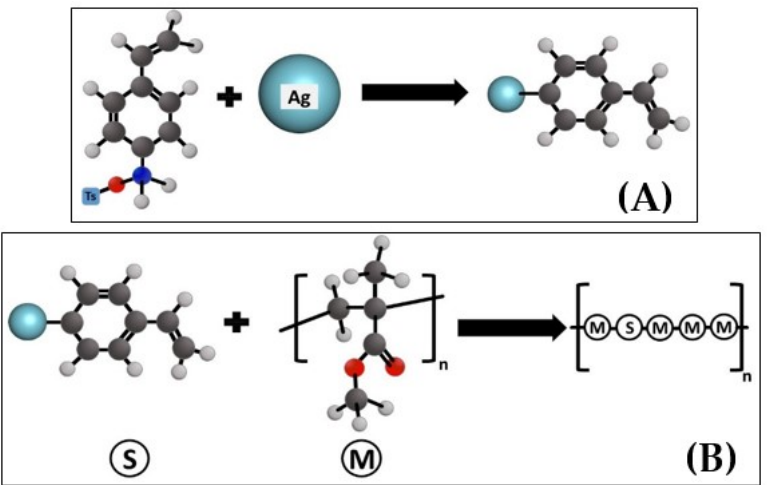
Figure 1. Schematic representation of AgNPs grafting with 4-aminostyrene ( A ); polymerization of the monomers mixed with modified AgNPs ( B ). Ts = p -toluenesulfonic acid monohydrate; S - styrene, M - monomer.